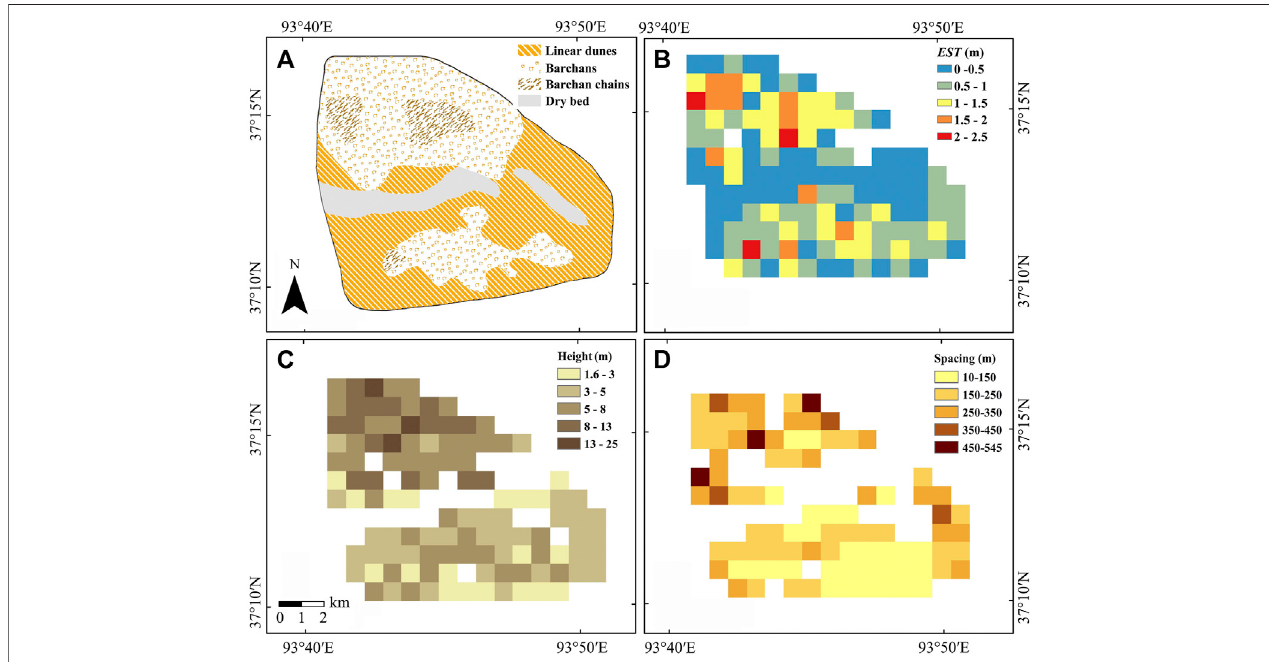
FIGURE9| Mapsofthe (A) dunedistribution, (B) equivalentsandthickness( EST ), (C) dunecrestheight,and (D) cresttocrestdunespacingforareaA1 (Figure1) .